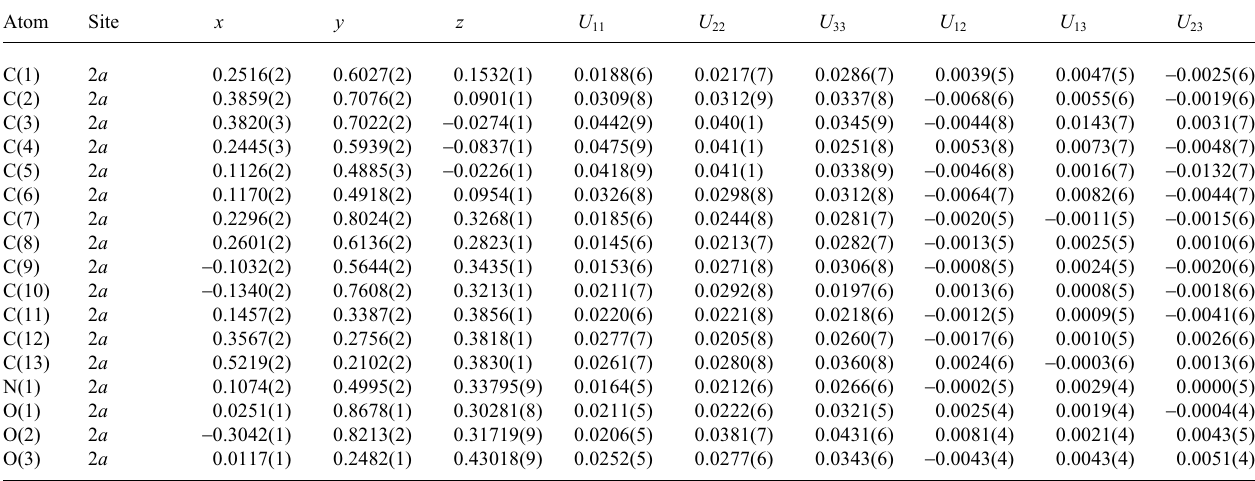
Table 3. Atomic coordinates and displacement parameters (in Å 2